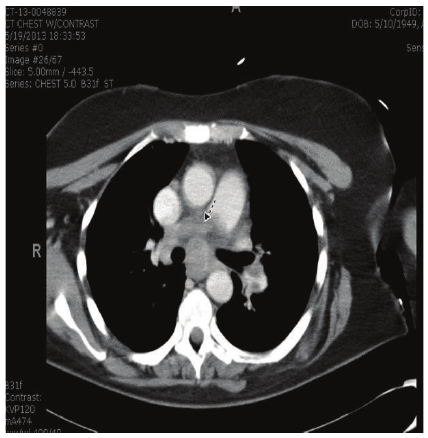
Figure 3: CT of the chest with arrow demarcating a saddle embolus.